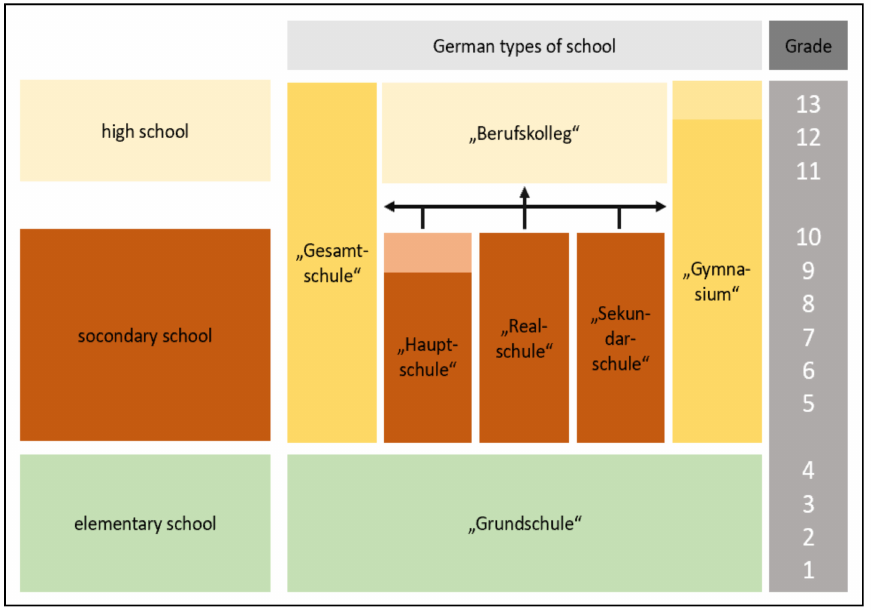
Figure 1. Overview of the German school system and its proper names (source: [15], with permission of the